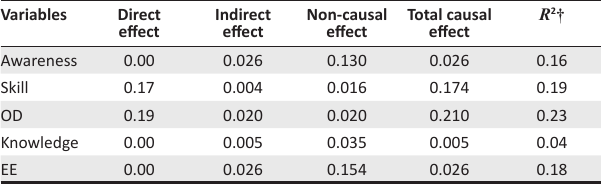
TABLE 10: The effects of disaster risk management variables on public participation.